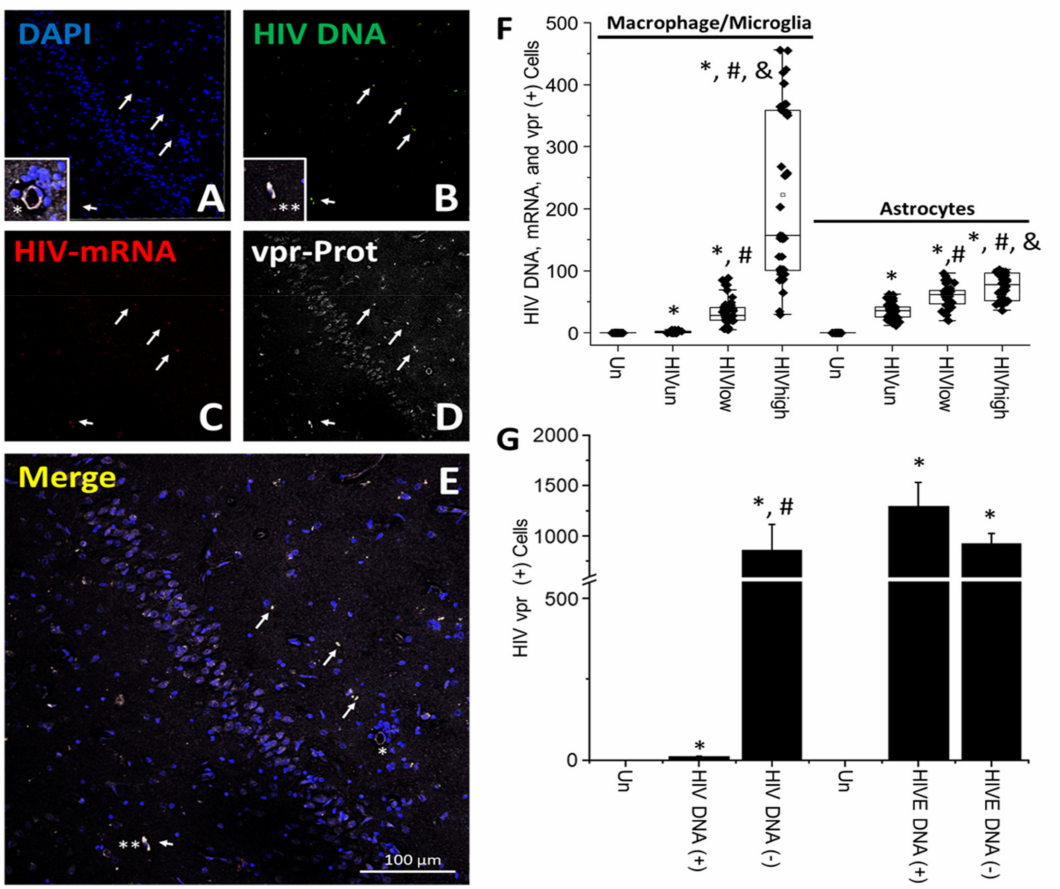
Figure 6. HIV-vpr is expressed in HIV-infected cells under effective ART. ( A – E ) Representative confocal images present the expression and distribution of Vpr protein in the HIV-infected